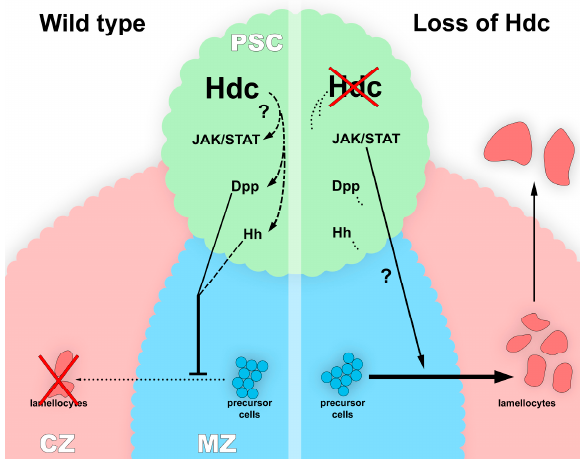
Figure 8. The proposed model of Hdc function in the regulation of signaling pathways in the PSC of the lymph gland. Genetic interactions suggest that Hdc regulates the Hh, the Dpp and the JAK/STAT signaling pathways in the cells of the PSC, thereby maintaining the precursor state of medullary zone (MZ) prohemocytes (left panel). In the lack of Hdc (right panel), the downregulation of the Hh and the Dpp pathways results in the differentiation of lamellocytes in the cortical zone (CZ) without immune induction.